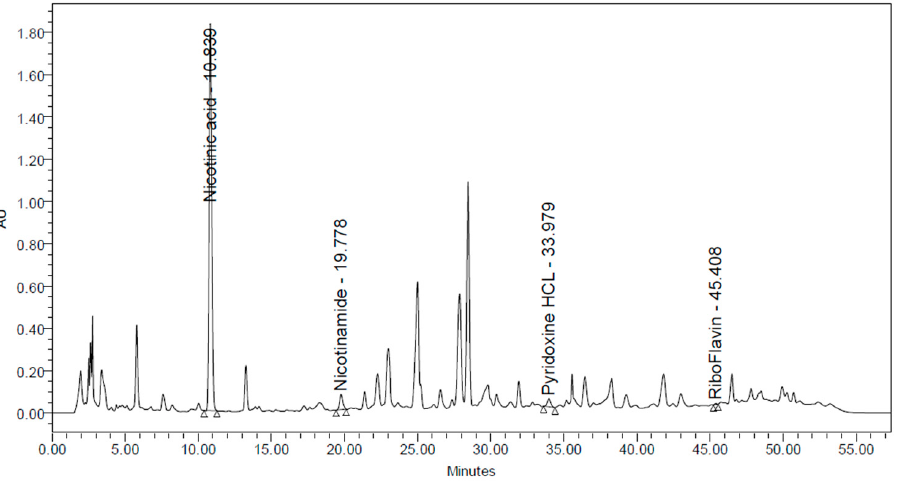
Figure 1. HPLC analysis of water-soluble vitamins in corn steep water obtained in the present study.